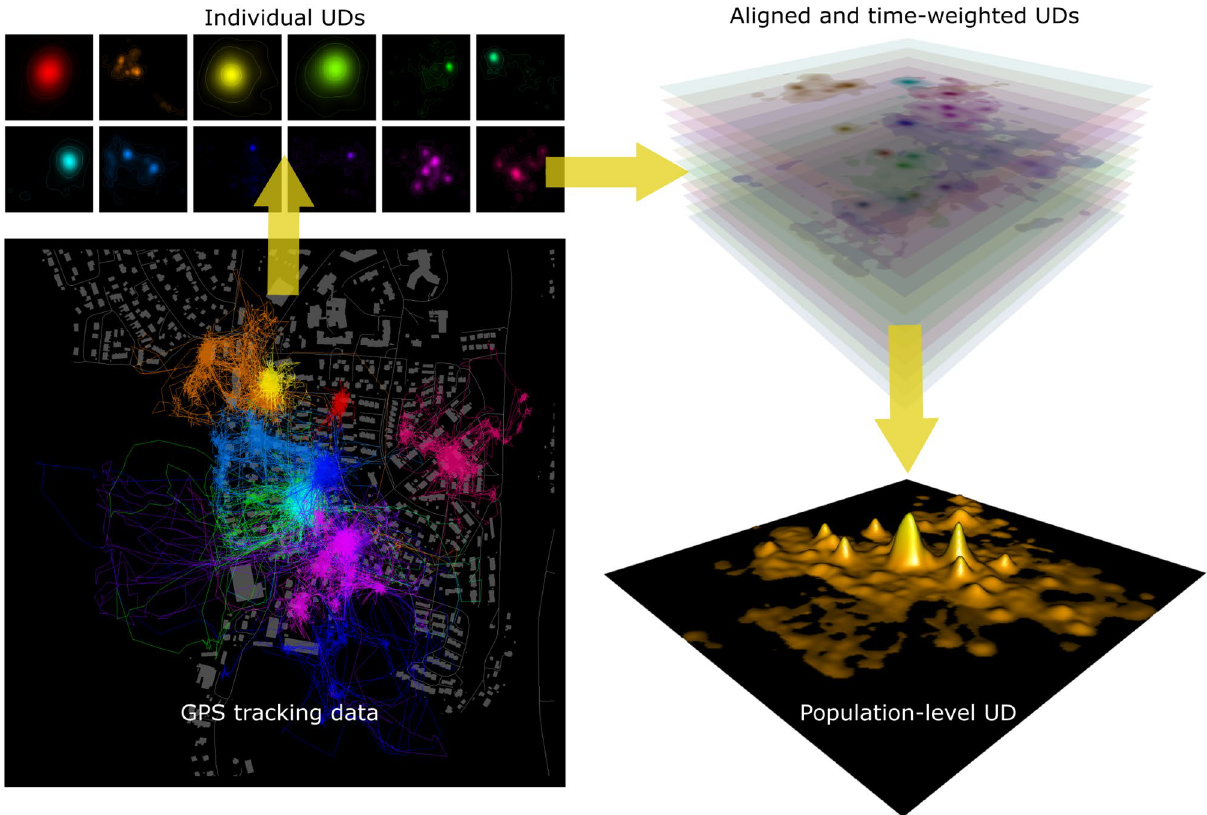
Figure 1. Illustration of the construction of the catscape by aggregating the utilization distributions (UDs) of 12 example pet cats in a suburban neighborhood (buildings shown in grey). High-throughput GPS data ( A ) are used to estimate individual UDs with Brownian bridge motion models ( B ). Individual UDs are weighted according to the average proportion of time spent outdoors on days with data ( C ) and are then summed across individuals to yield the combined intensity of use ( D ). All maps (2D and 3D) were created using R 17